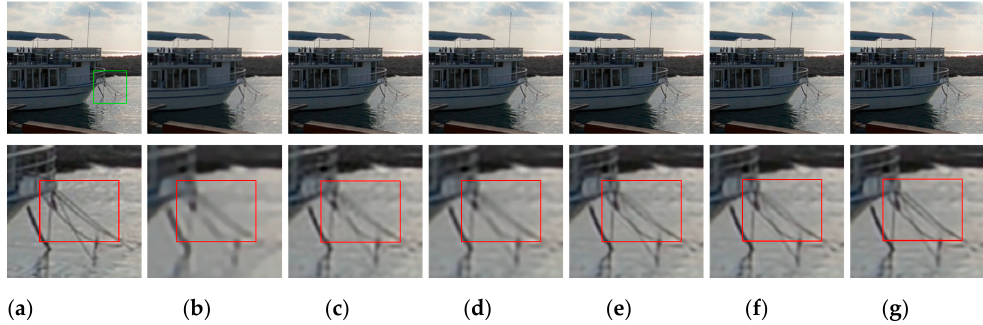
Figure 9. Deblurred results for test image with 17 × 17 Gaussian blur kernel of deviation 1.6. The first row shows the sharp image and deblurred images for the evaluated methods. The second row shows the enlarged views of the region marked with the green box in the original image and the deblurred